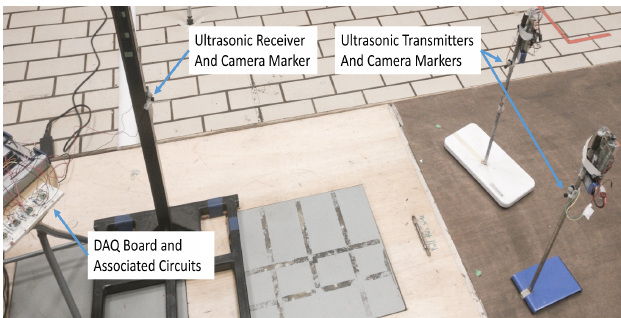
Figure 5. The experimental setup to study the multiple access